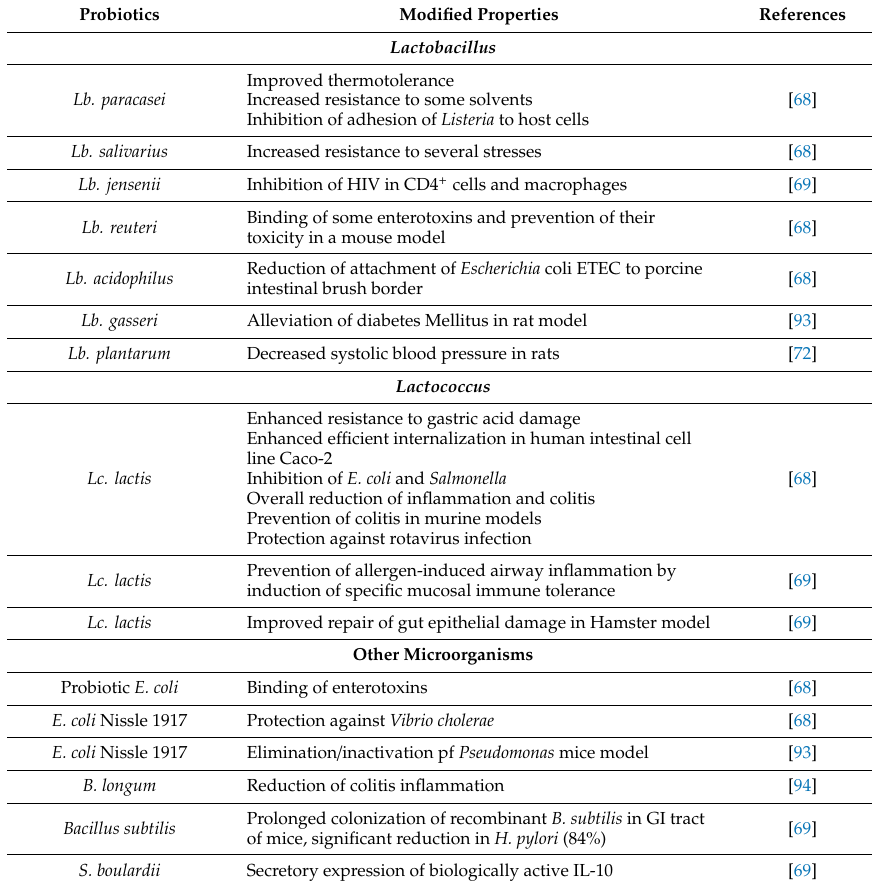
Table 4. Bioengineered microorganisms intended as probiotics in humans. Lb., Lactobacillus ; S., Saccharomyces ; Lc., Lactococcus ; E., Escherichia